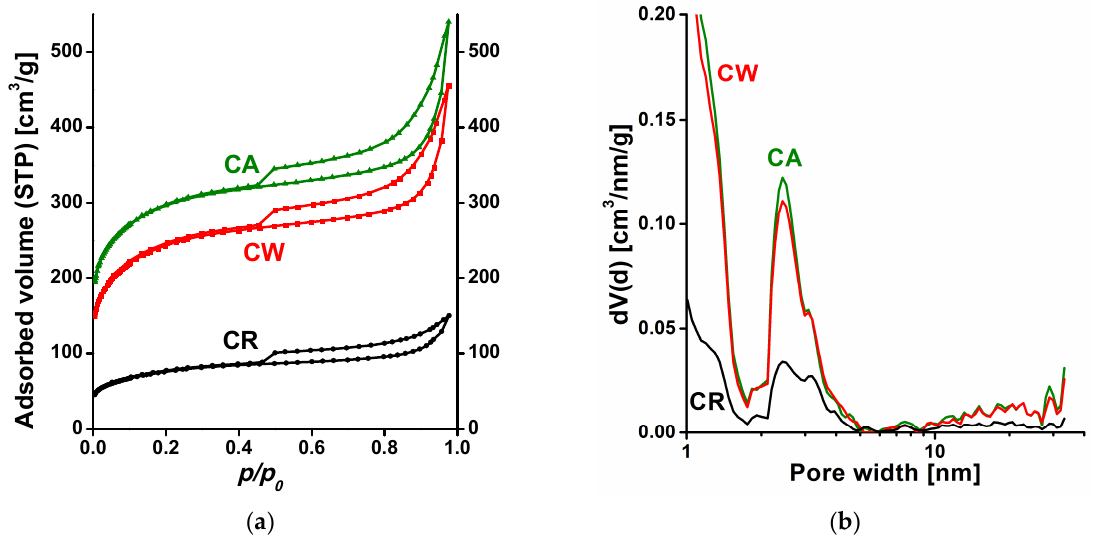
Figure 2. ( a ) Low temperature N 2 adsorption/desorption isotherms; ( b ) Pore size distribution functions were estimated by quenched solid density functional theory (QSDFT) (Kernel: N 2 at 77 K on carbon, slit/cylindrical pores, adsorption